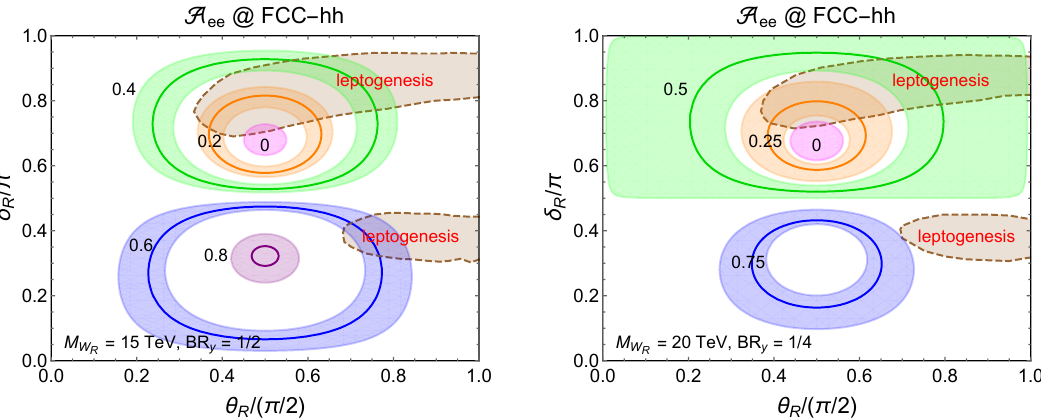
Figure 4. Contours of at future 100 TeV collider FCC-hh, as functions of the RHN mixing A ee angle (cid:18) R and CP phase (cid:14) R . Here we have (cid:12)xed the RHN mass at 1 TeV. In the left panel, we show the lines with = 0 : 8, 0.6, 0.4, 0.2 and 0, with W R mass at 15 TeV and BR y = 1 = 2, while in A ee the right panel we show the contours of = 0 : 75, 0.5, 0.25, and 0, with W R mass at 20 TeV A ee and BR y = 1 = 4. The shaded bands are due to the PDF uncertainties. The brown shaded regions bounded by the dashed lines in the left and right panels are respectively the regions covered by the blue and red points in (cid:12)gure 10, which could generate successful leptogenesis; see section 5.3 for more details on the leptogenesis